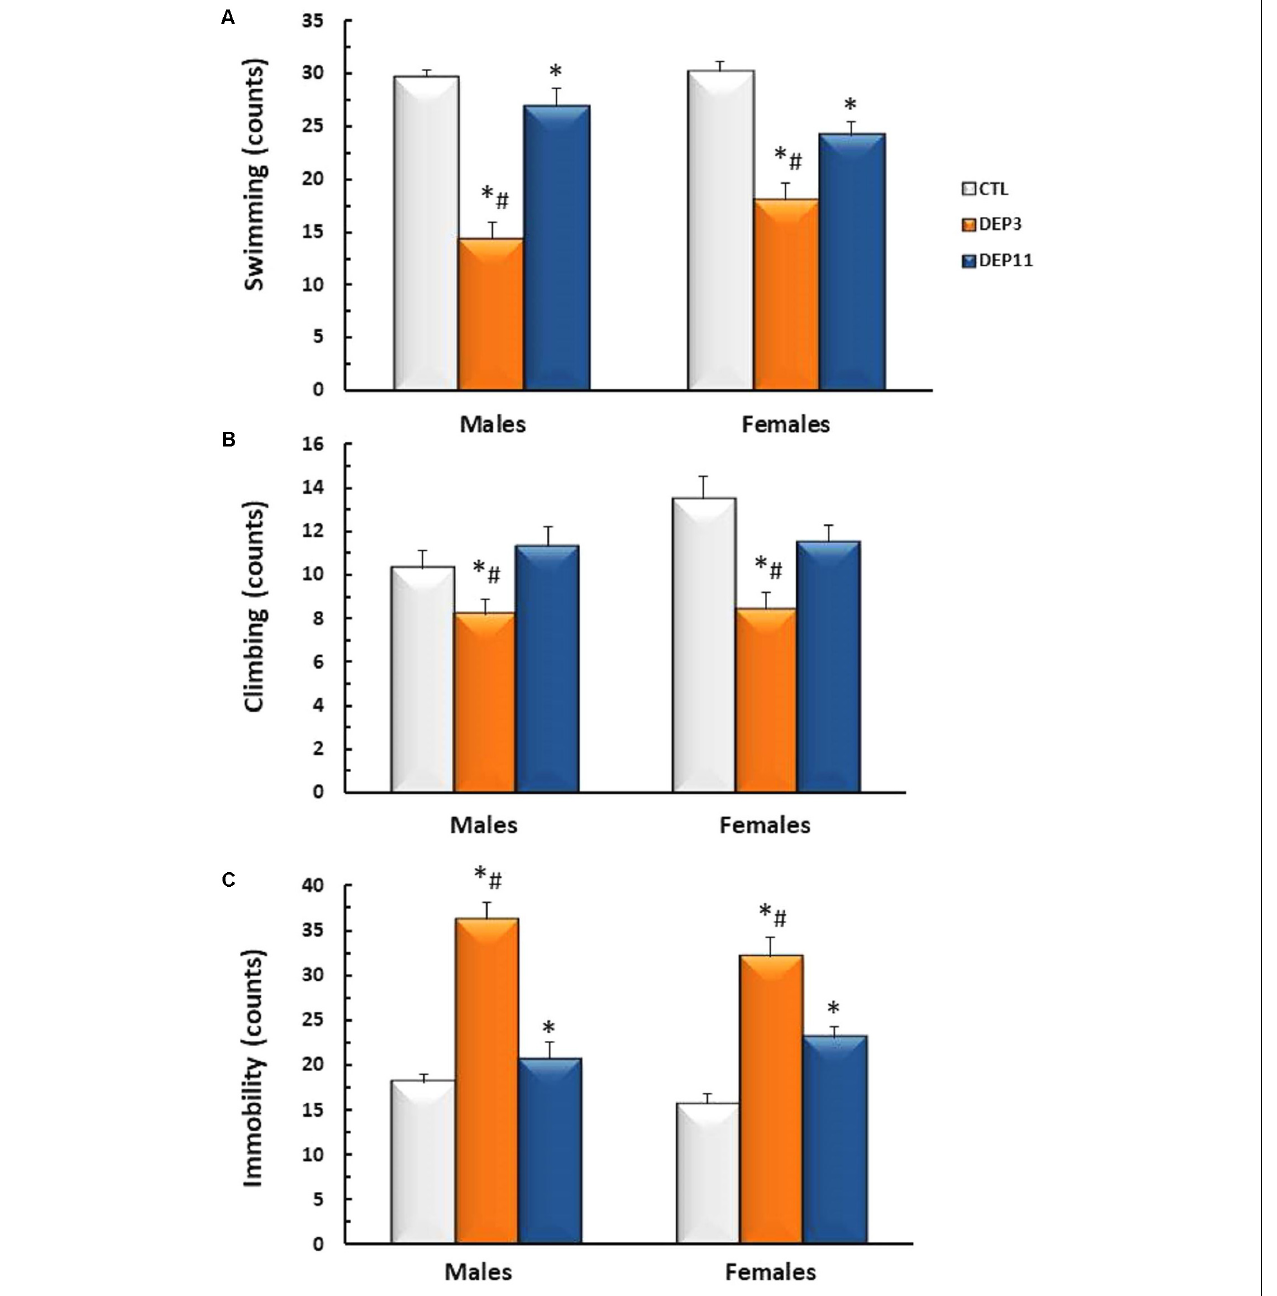
FIGURE 3 | Frequency of swimming (A) , climbing (B) , and immobility (C) during a 5 min session of the forced swimming test. Animals were maintained with their mothers (CTL), deprived on postnatal day (PND) 3 (DEP3) or on PND 11 (DEP11) and tested between PNDs 52 and 60. Data are presented as mean ± SEM of 10 animals/group/sex. ∗ – Different from CTL group; # – different from